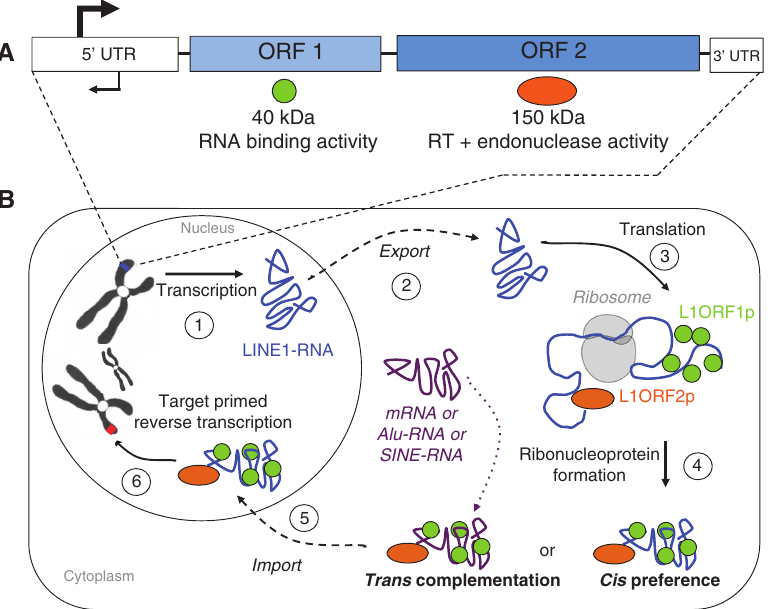
Figure 1 Schematic representation of L1 structure and retrotransposition